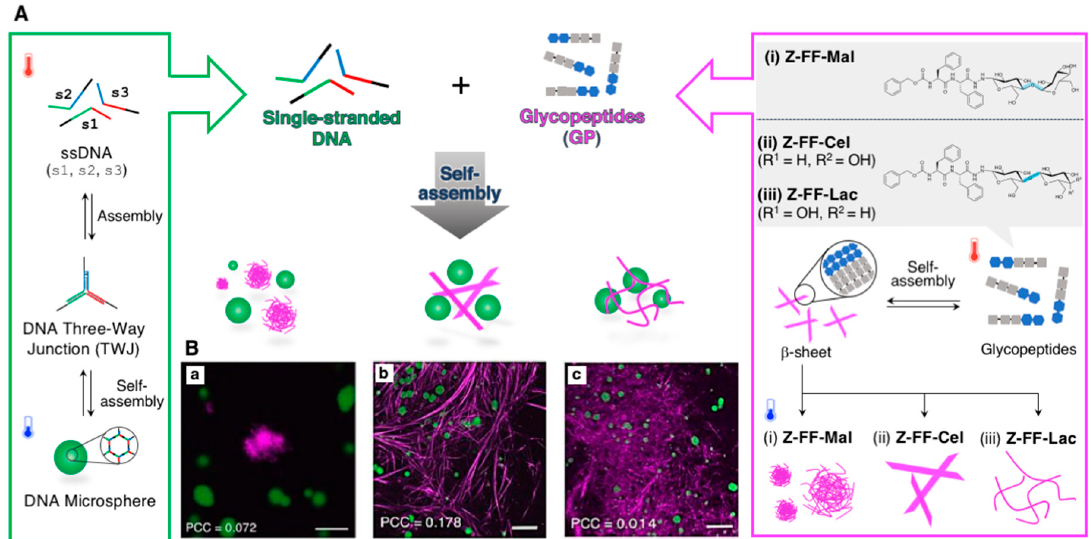
Figure 9. ( A ) Schematic illustration of the orthogonal self-assembly of semi-artificial glycopeptides (right panel) and ssDNAs (left panel) to produce hybrid soft materials that comprised supramolecular nanostructures of glycopeptide and DNA microspheres. ( B ) Representative confocal laser scanning microscopy (CLSM) images showing the orthogonal coexistence of DNA microsphere and the supramolecular nanostructures of ( a ) Z-FF-Mal , ( b ) Z-FF-Cel , and ( c ) Z-FF-Lac . Scale bar: 5 µ m for a and 10 µ m for b , c . Adapted from [76]. Copyright 2019 John Wiley and Sons Publisher.